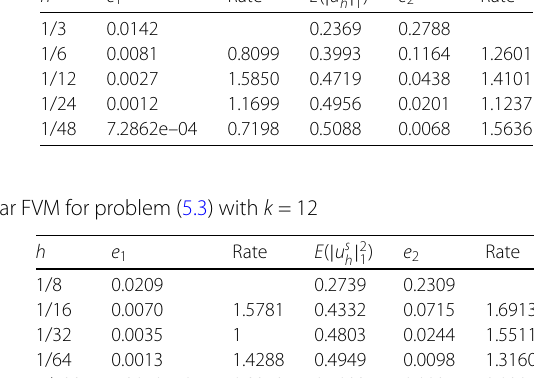
Table 14 The linear FVM for problem (5.3) with k = 6 h e 1